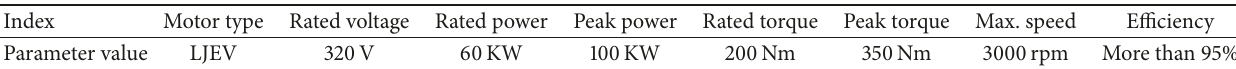
Table 4: Performance parameters of